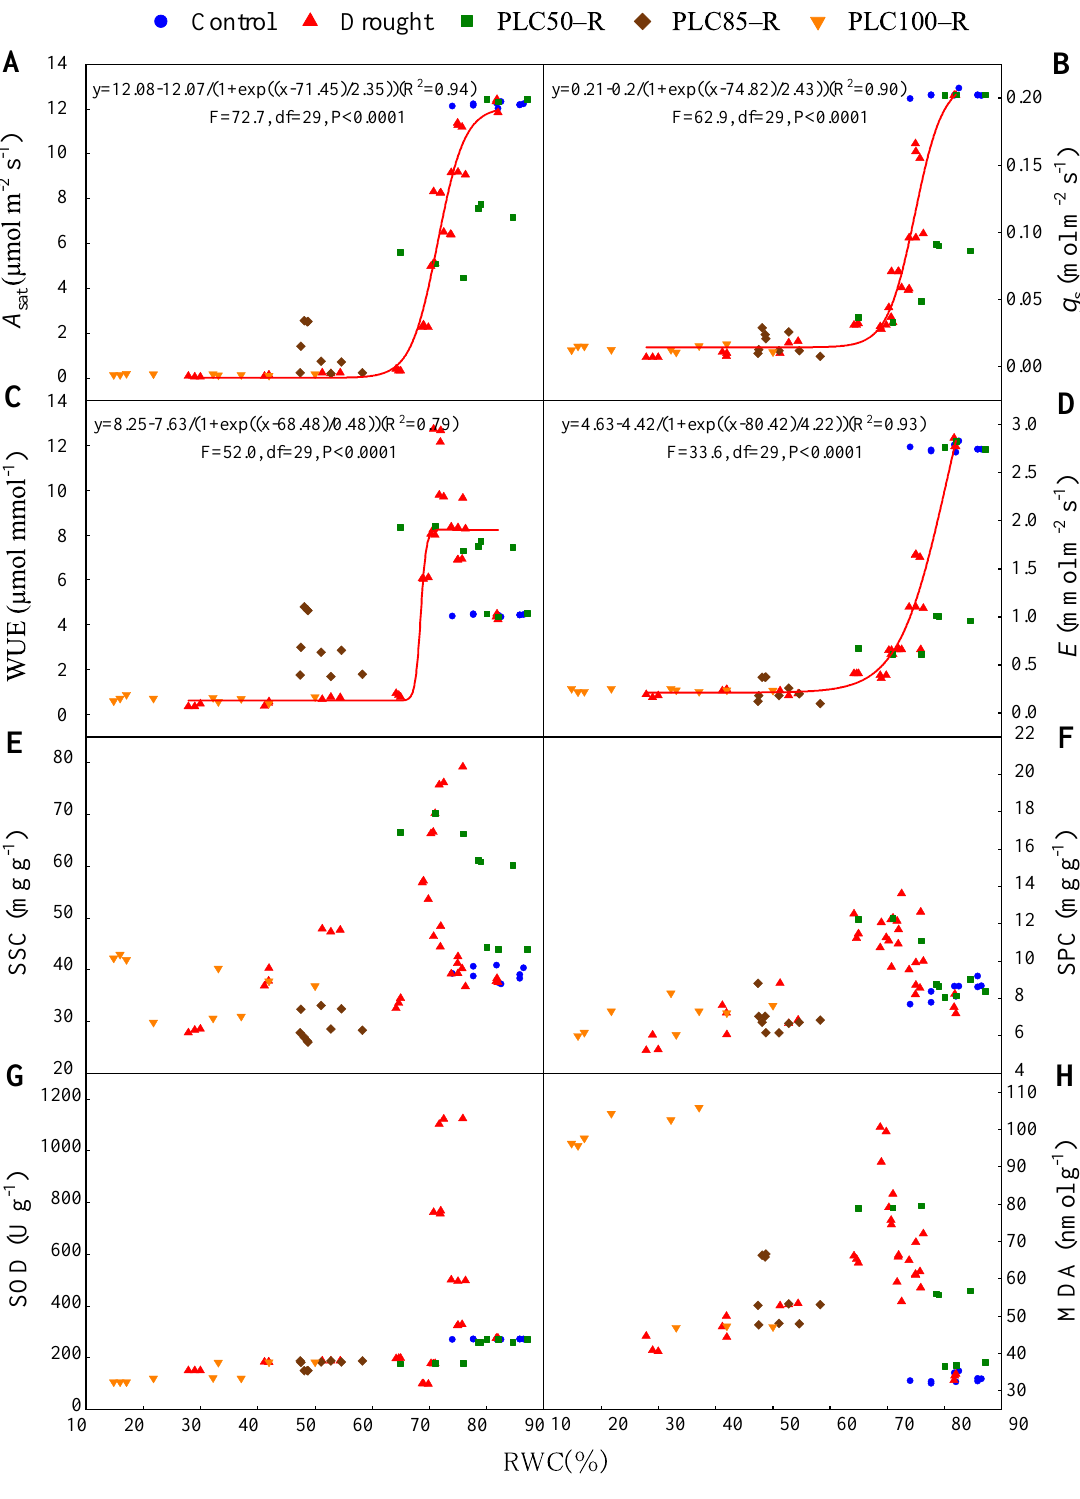
Figure 5. During drought and rehydration, the photosynthetic rate ( A sat ) ( A ), stomatal conductance ( g s ) ( B ), water use efficiency (WUE) ( C ), transpiration rate ( E ) ( D ), soluble sugar content (SSC) ( E ), soluble protein content (SPC) ( F ), superoxide dismutase (SOD) activity ( G ), and malondialdehyde (MDA) content ( H ) are presented as functions of relative water content of needles. Raw data points are shown. Note: the curves were fitted with sigmoidal function only using drought